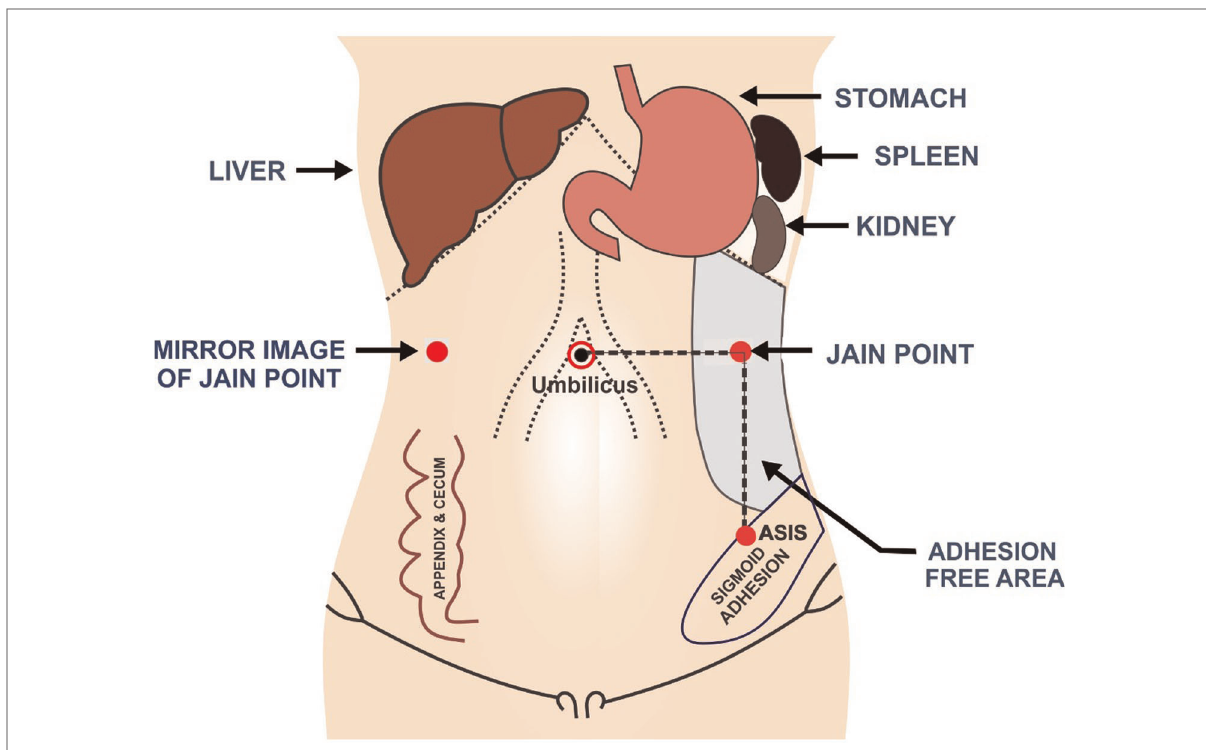
FIGURE 3 Jain point is at the L4 level, 10-13 cm lateral to umbilicus and away from both the viscera on the left side (spleen, kidney, and bloated stomach) and the sigmoid colon in a wide nascent area on the left side from L1 to pelvic, which is free from vessel, viscera, adhesions, and